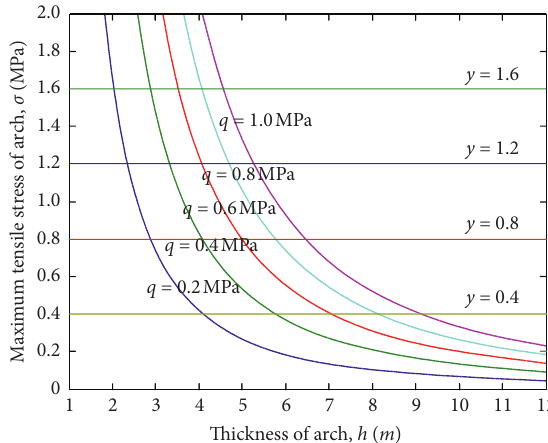
Figure 9: Relationship between beam stress and overburden rock layer load and arch thickness.